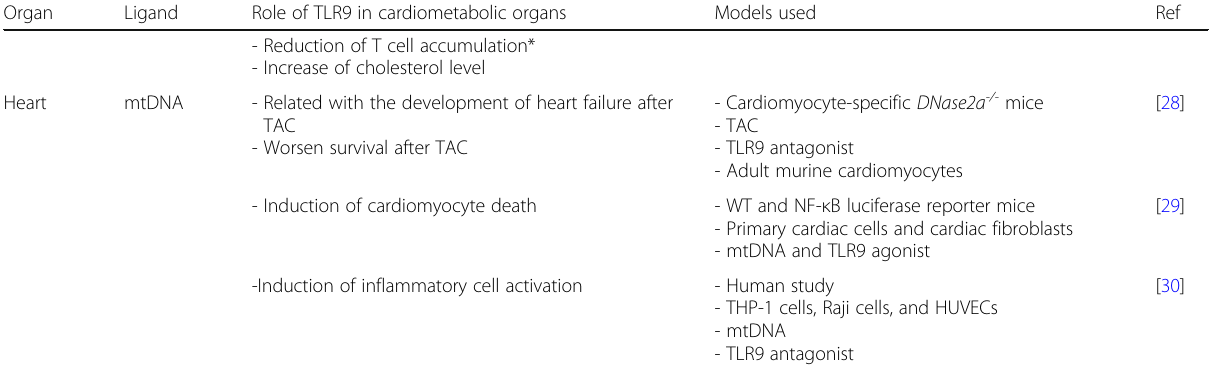
Table 1 Potential ligands and roles of TLR9 in cardiometabolic disorders (Continued) Organ Ligand Role of TLR9 in cardiometabolic organs Models